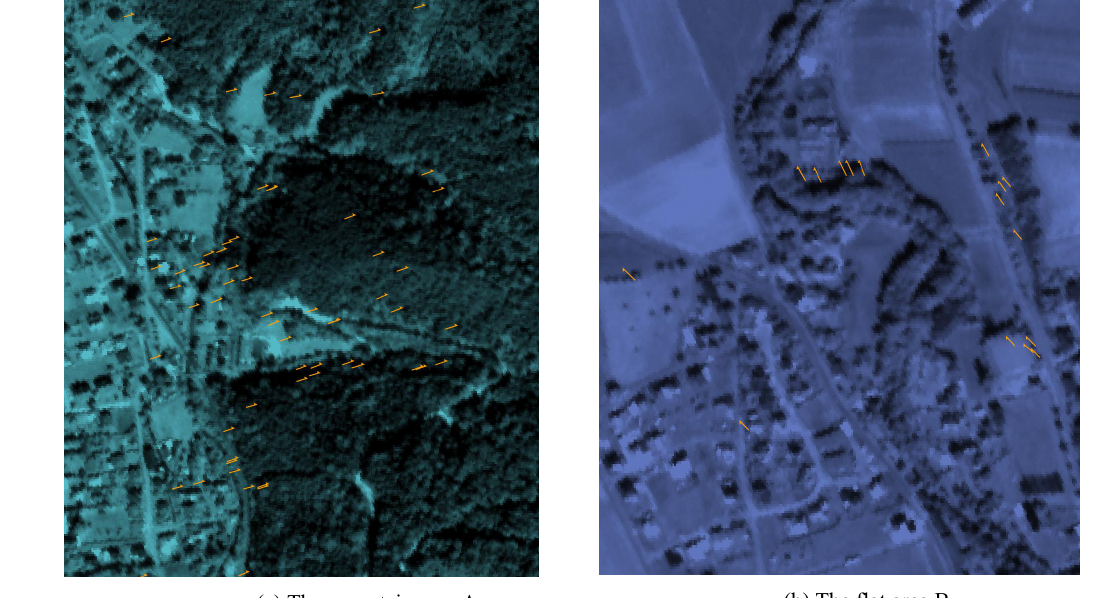
Figure 4. The regional distribution of the deviations of checking